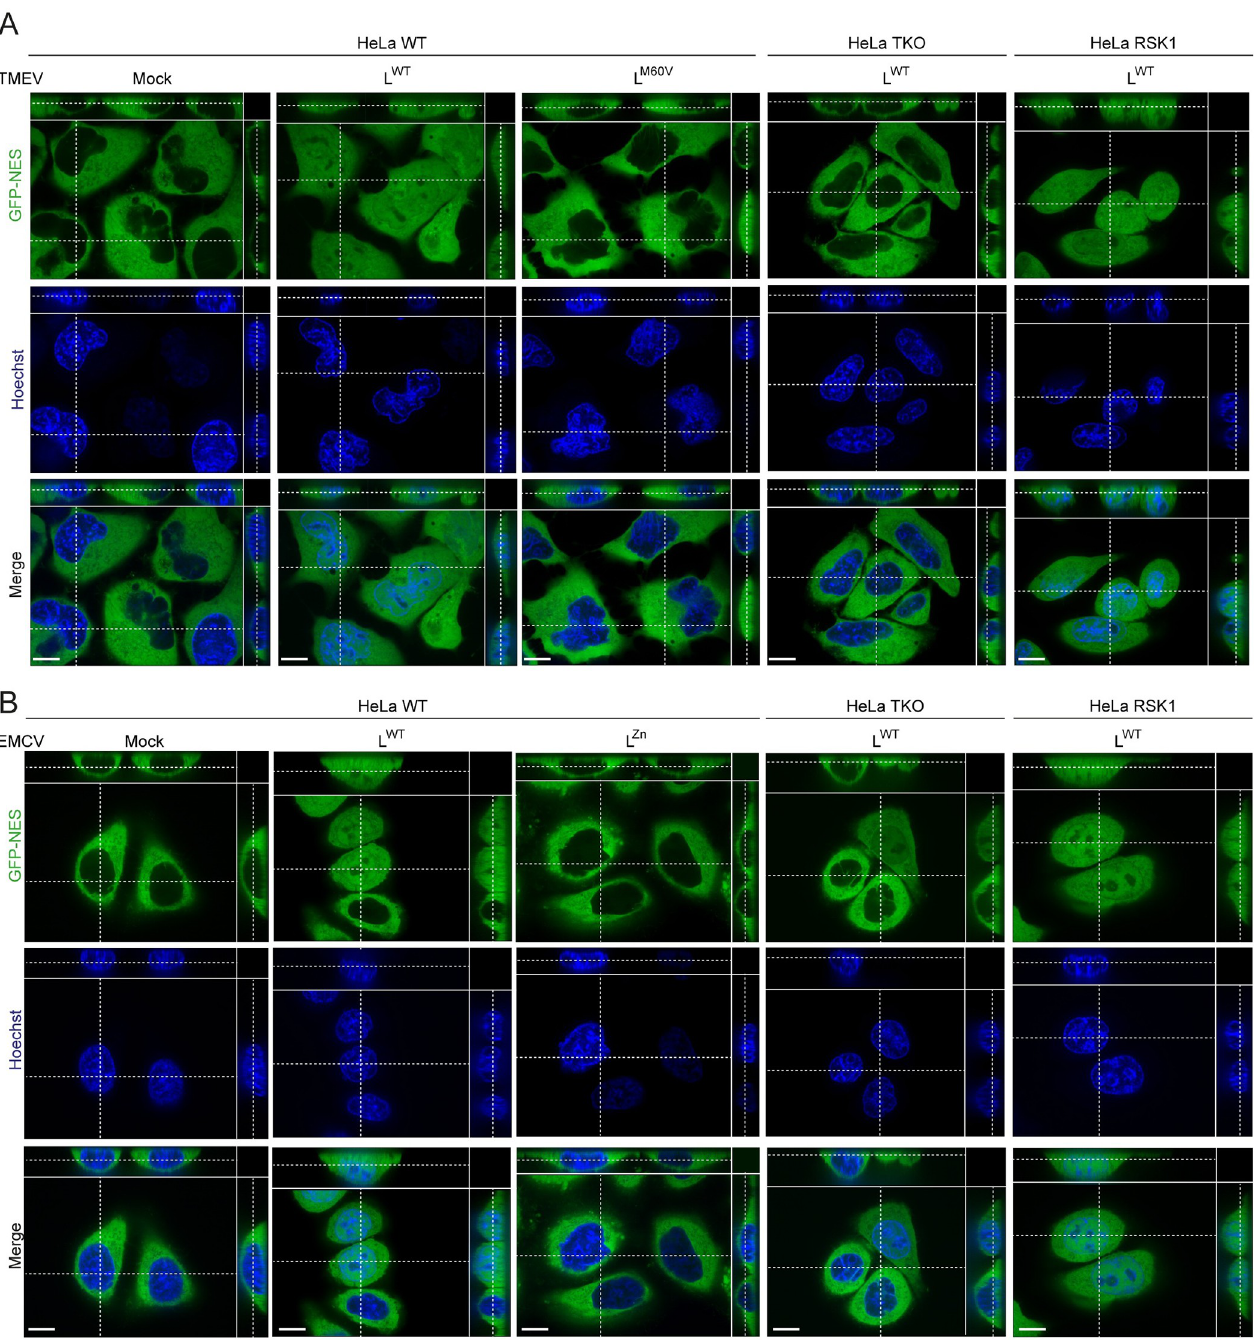
Fig 4. GFP-NES diffusion in TMEV and EMCV infected cells. (A-B) Z-stack confocal microscopy images showing GFP-NES diffusion in live HeLa-LVX cells infected with TMEV for 10h to 11h (A) or EMCV for 4h30 to 5h30 (B). HeLa LVX cells were either WT, or RSK-TKO cells transduced with an empty vector (HeLa TKO) or re-expressing RSK1 (HeLa RSK1). Scale bar: 10 μ m.